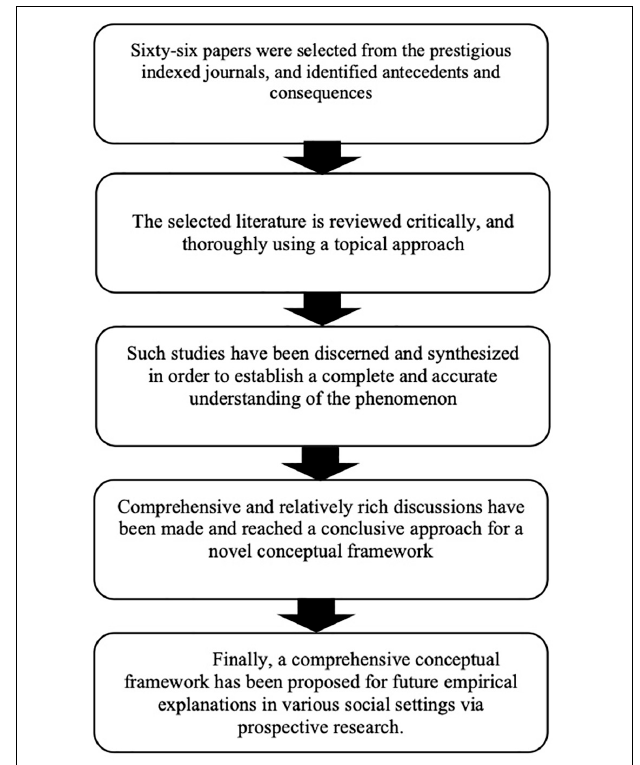
FIGURE 1 | Flow of ideas for novel conceptual